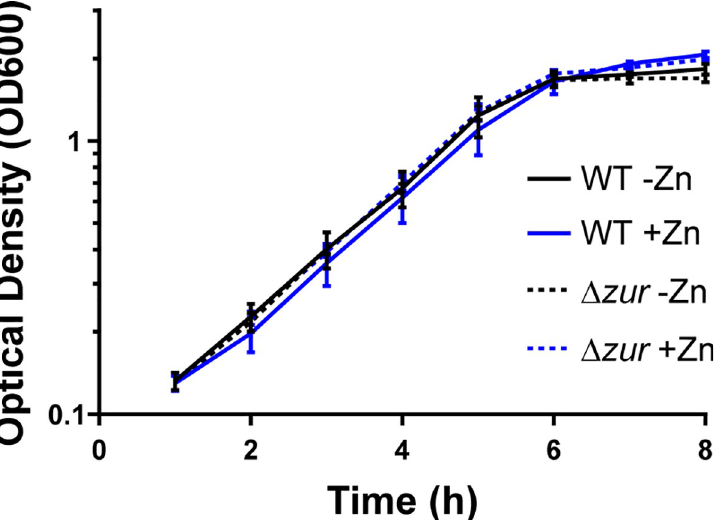
Fig 1. Growth of C . diphtheriae wild type and zur deletion mutant in low-metal media. Wild-type C . diphtheriae strain 1737 (solid lines) and an isogenic zur mutant (dashed lines) were grown in mPGT medium without (black, -Zn) or with (blue, +Zn) zinc chloride at a final concentration of 5 μ M. The data are the mean and standard deviation of four biological replicates. Samples were collected for RNA extraction at 4 h with an OD600 of 0.5–0.7.